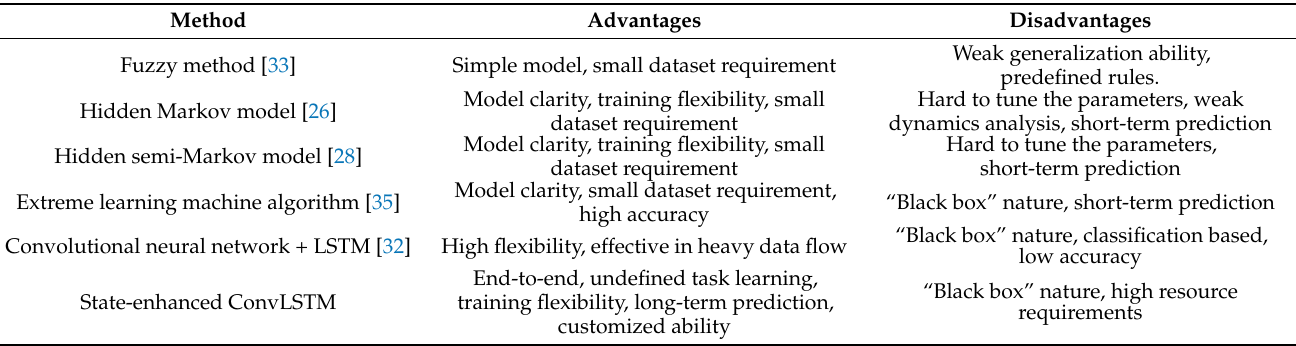
Table 1. The comparison of different methods in human action